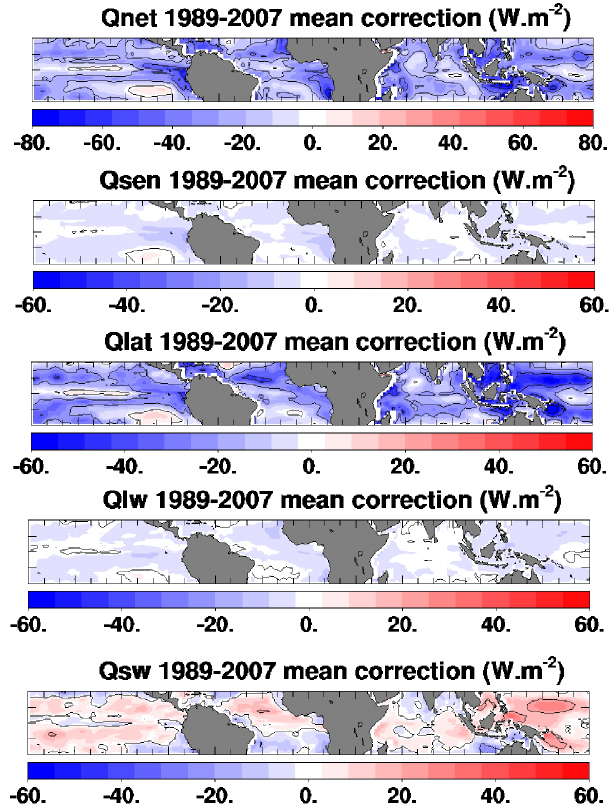
Fig. 7. 1989–2007 means of net heat-flux correction, radiative heat- flux corrections and turbulent heat-flux corrections in the 20 ◦ N– 20 ◦ S latitude